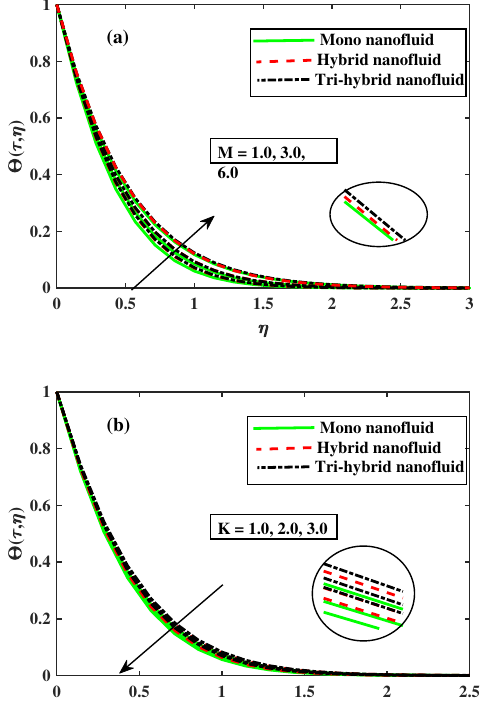
Figure 4. ( a ) Fluctuation of M on θ ( τ , η ) ; ( b ) Fluctuation of K on θ ( τ , η )